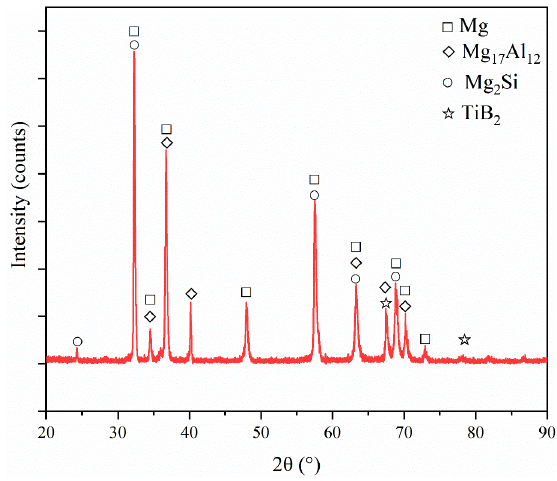
Figure 4. XRD patterns of the as-cast TiB 2 /Mg-4Al-1.5Si composites.